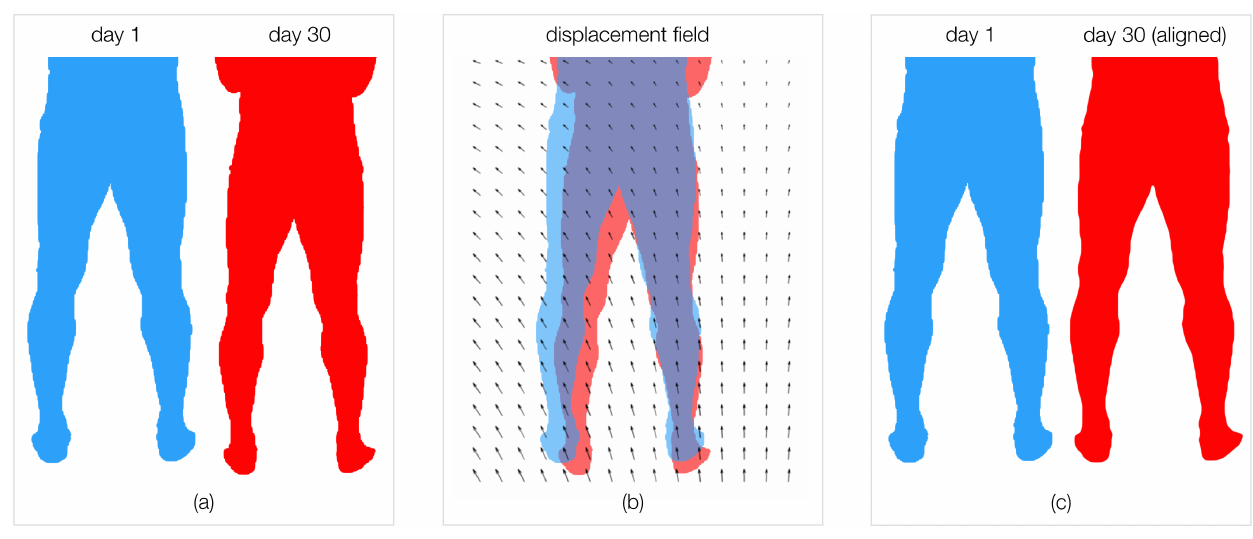
Figure 6. Registration of thermograms of a player, acquired one-month apart. ( a ) Masks at Days 1 and 30; ( b ) unregistered masks superimposed and the displacement field; ( c ) mask at Day 30 aligned with the coordinate system of the mask at Day